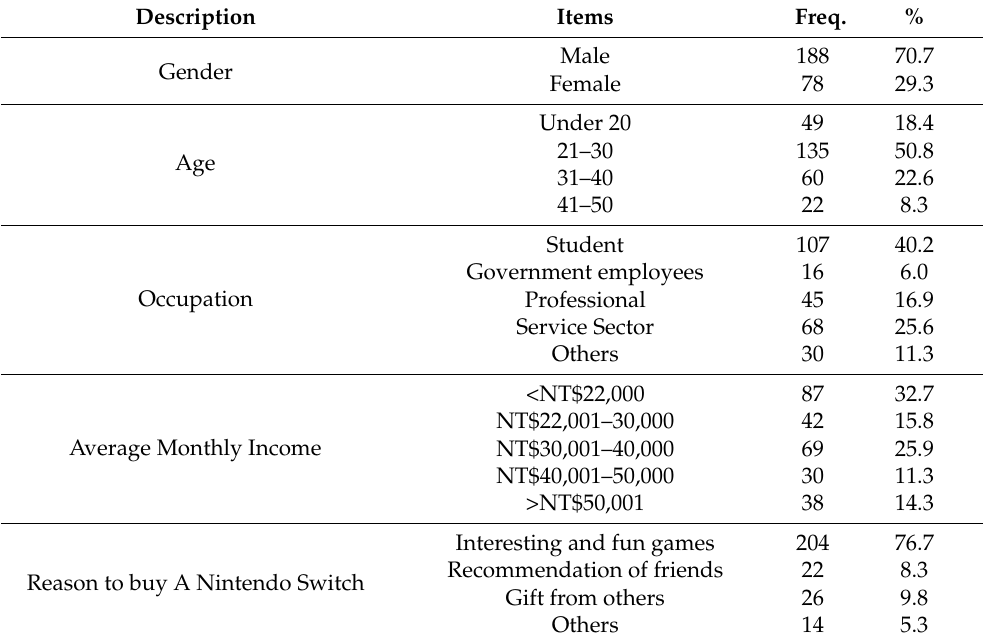
Table 1. Profile of the